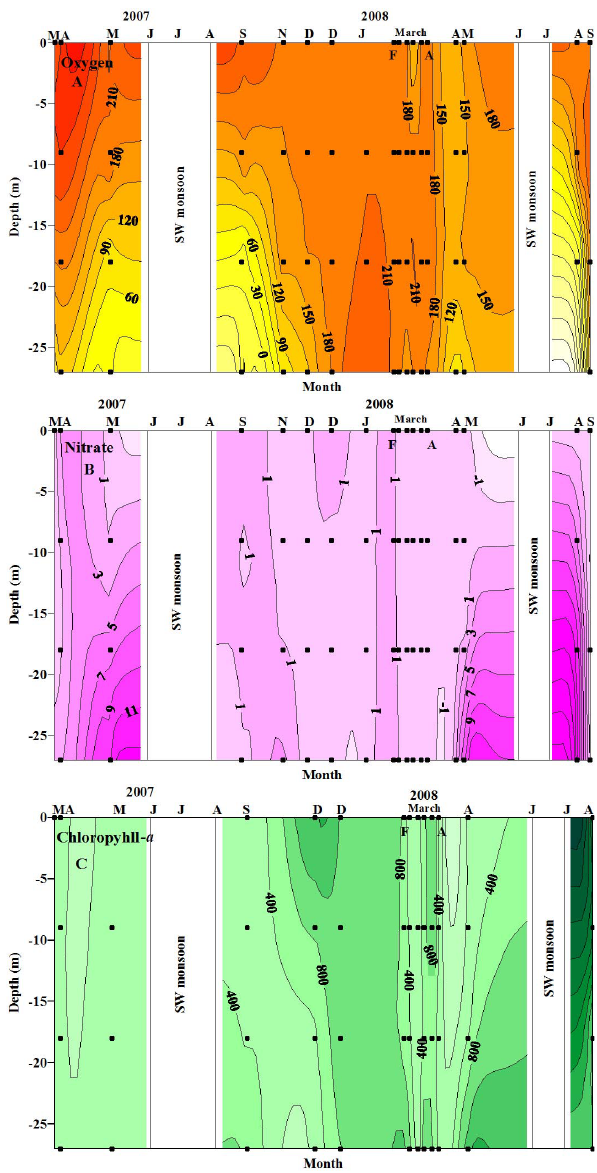
Fig. 2. Variations with depth and time in dissolved O 2 µM (A) , nitrate µM (B) and chlorophyll- a ngl − 1 (C) at the CaTS site from March 2007 to September 2008. Note that observations could not be made during the SW monsoon due to rough weather.